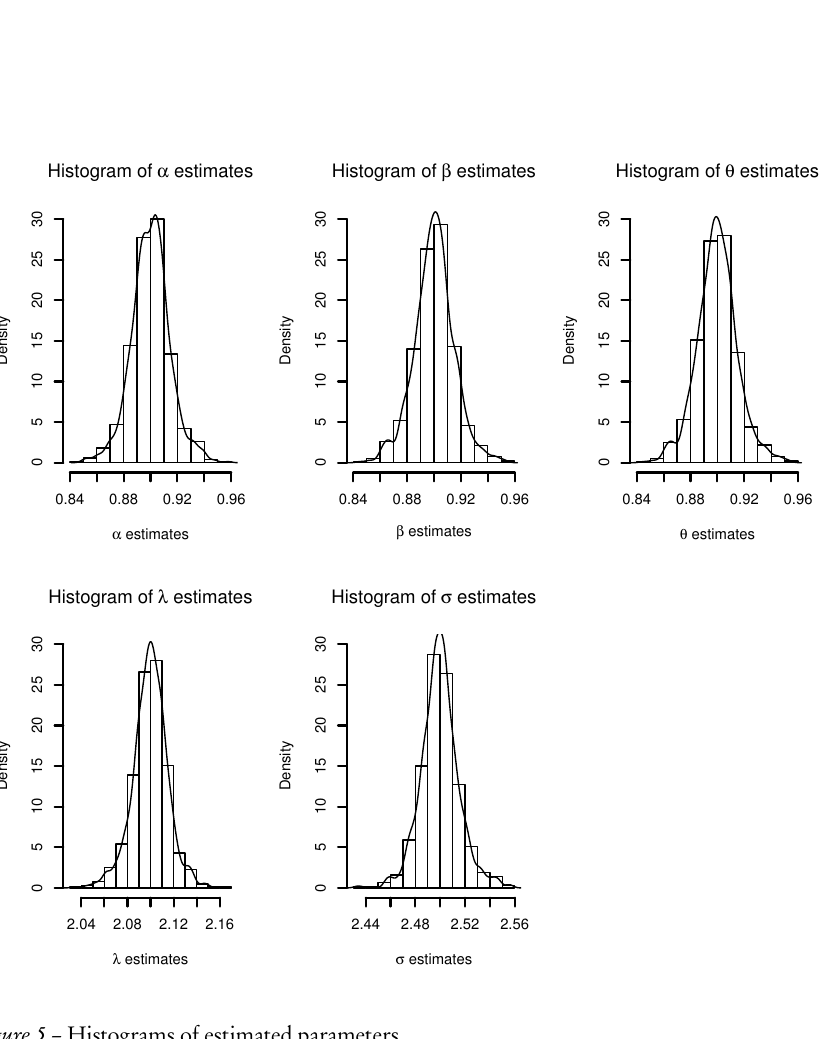
Figure 5 – Histograms of estimated